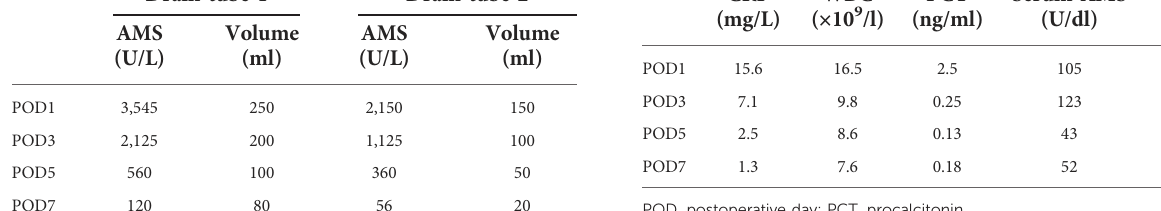
POD, postoperative day; PCT,